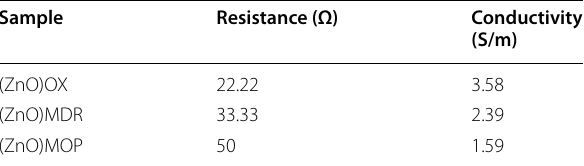
Table 3 The resistance and conductivity of zinc oxide nanoparticles obtained using the three preparation methods Sample